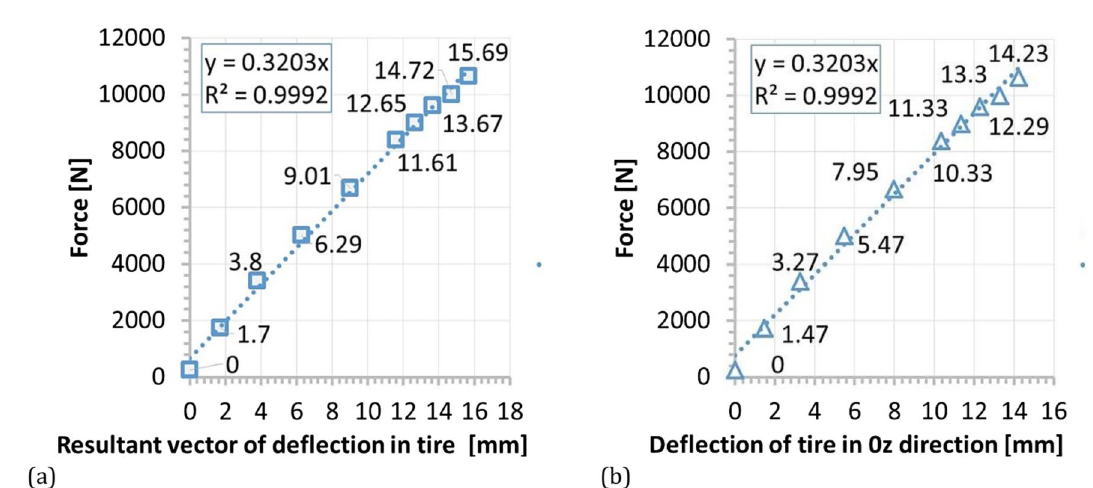
Figure 10. Force versus: ( a ) resultant vector of deflection in tire; ( b ) deflection of tire in the 0z